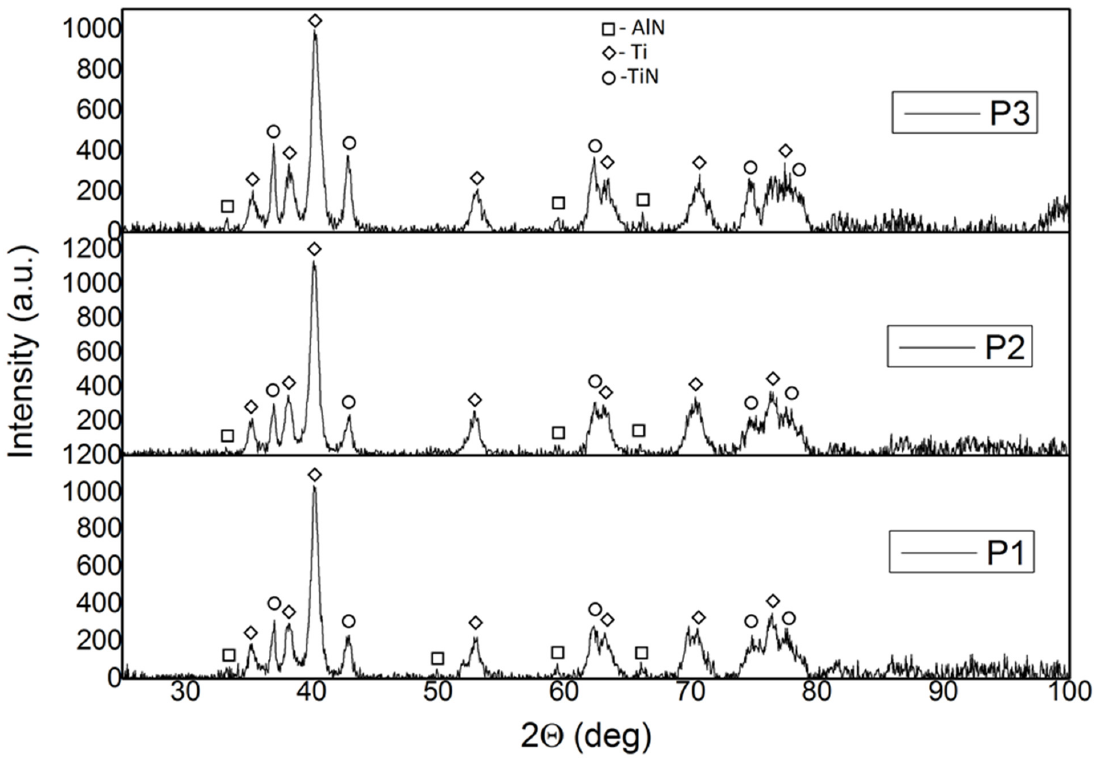
Figure 6. Diffraction patterns of P1 , P2, and P3 samples produced by the Selective Laser Melting (SLM) technique. (SLM) technique.